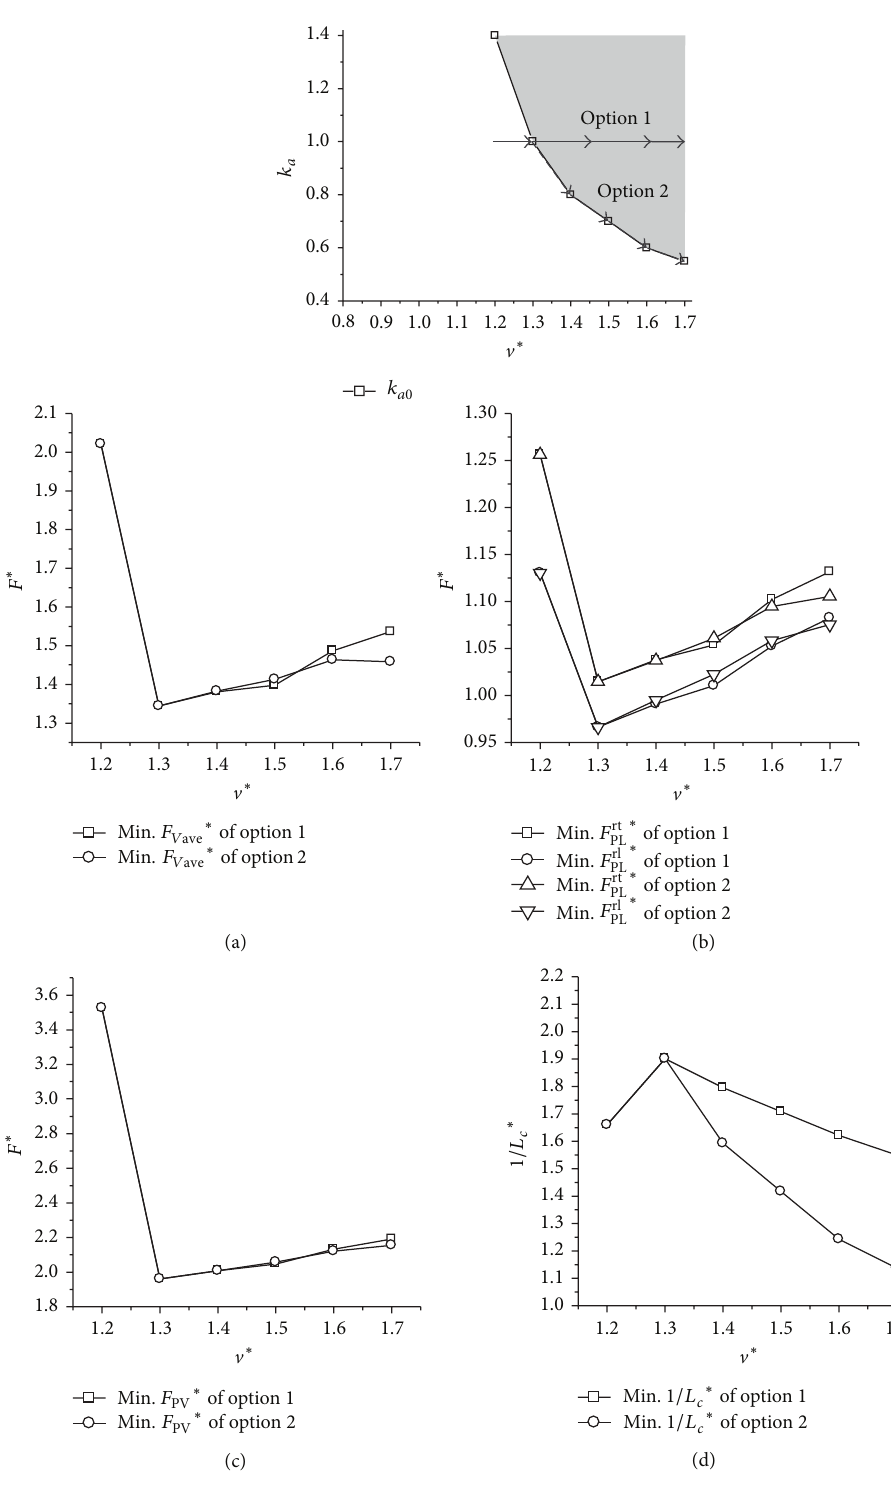
Figure 7: The performances of the dynamic system under two different options of 𝑘 𝑎 . (a), (b), and (c) represent the results of the average vertical force, peak leg force, and peak ground reaction force, respectively. (d) is the result of the indicator of the metabolic cost of transport. Initial conditions: 𝑦 ∗ 𝑠 = 1 , 𝜇 = 0.05 , and 𝑝 = 1.0